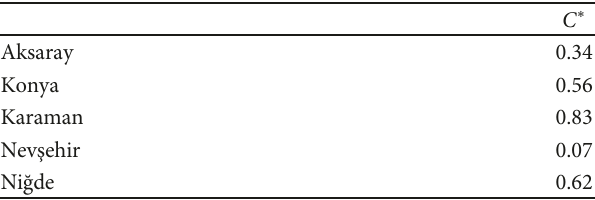
Table 8: Proximity values based on ideal